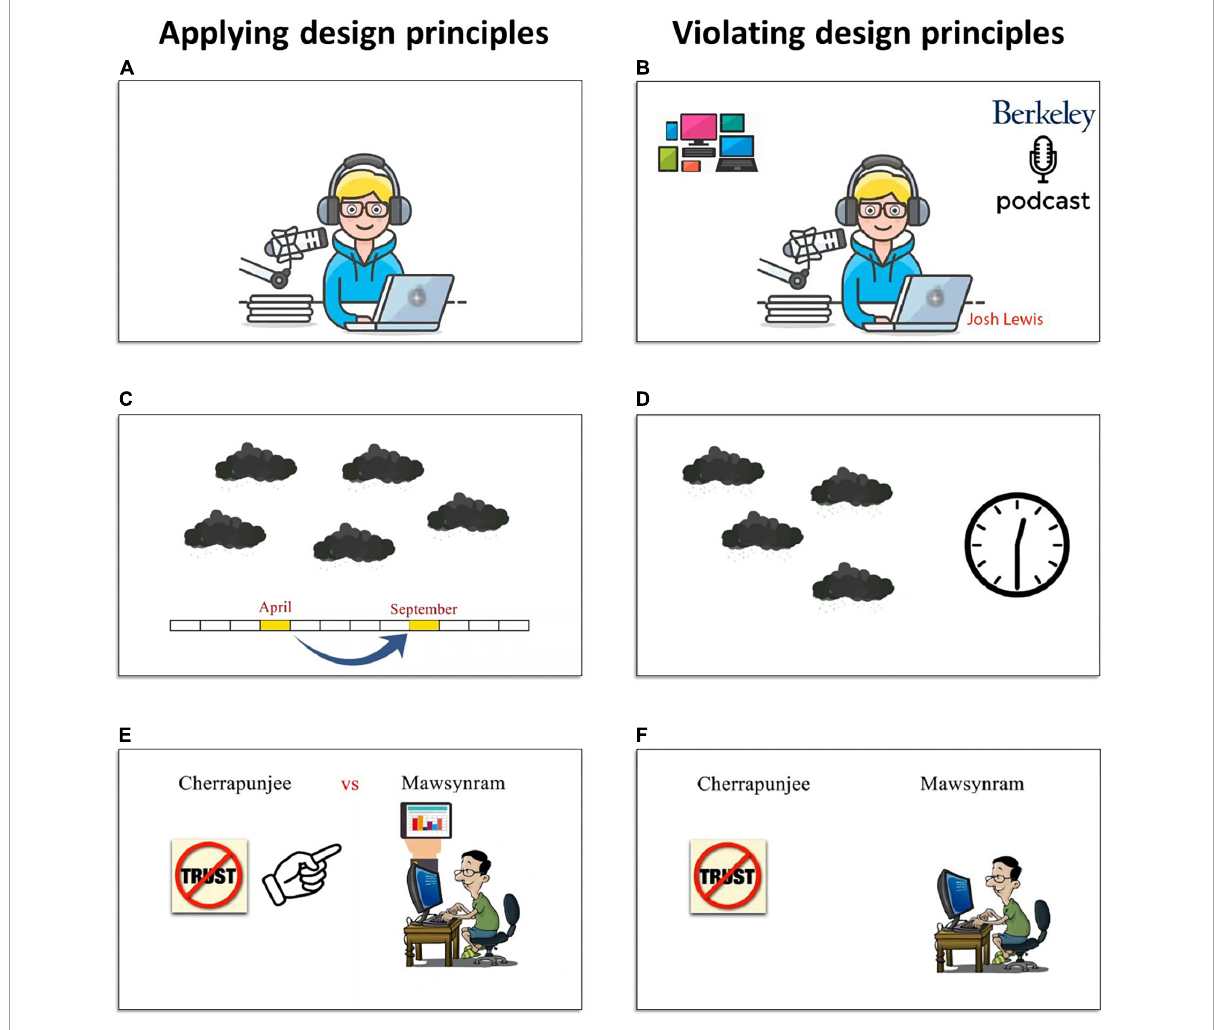
FIGURE2 Educational multimedia. Examples of application (i.e., left panels: A,C,E )/violation (i.e., right panels: B,D,F ) of multimedia design